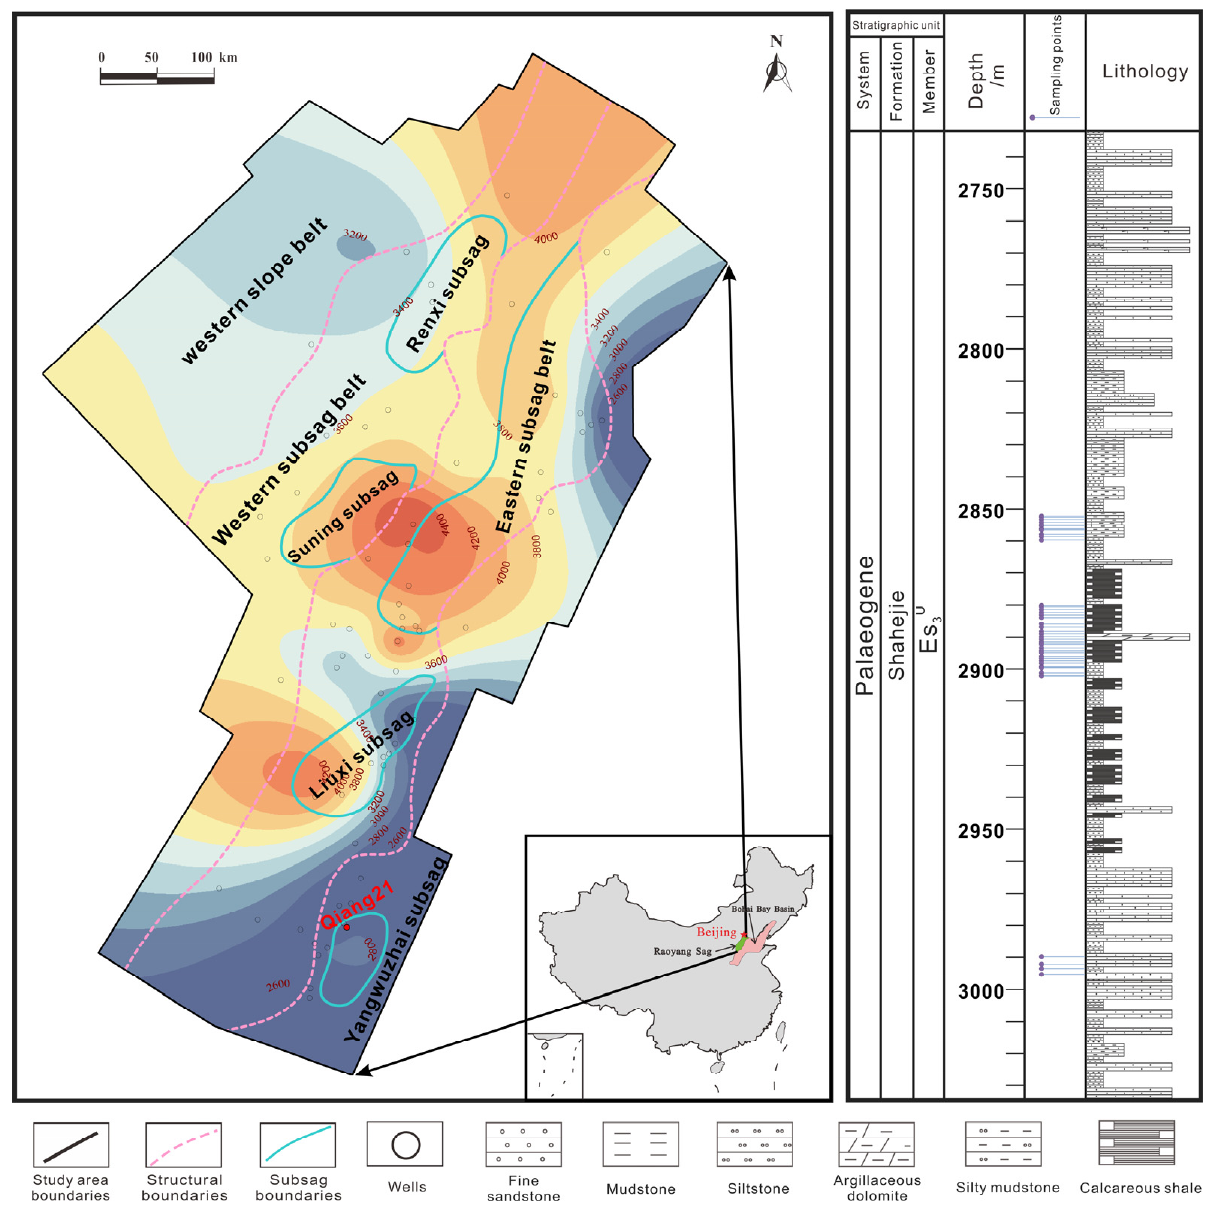
Figure 1. Locations of the study area and the key wells.